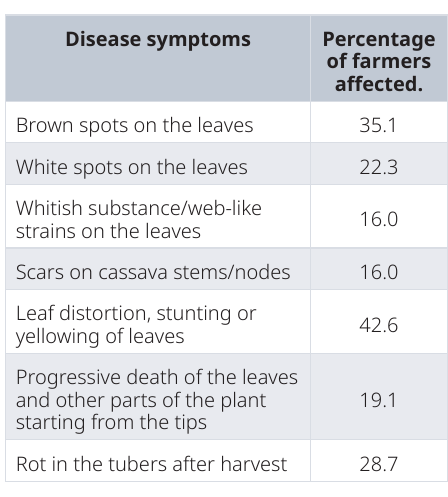
Table 4. Farmers Response to Disease- symptom statements.